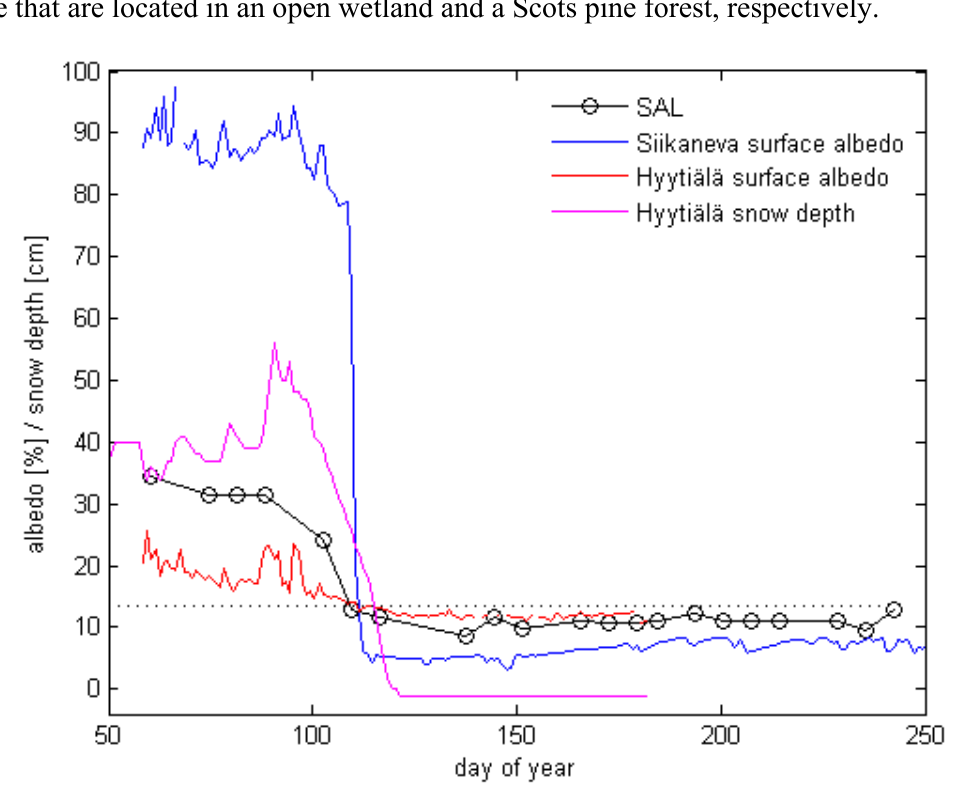
Figure 1. Time series of albedo values in Southern Finland in 2006. The coordinates of the selected SAL grid square are 61 ° 48’N, 24 ° 11’E. Siikaneva (61 ° 50’N, 24 ° 12’E) and Hyytiälä (61 ° 51’N, 24 ° 17’E) are surface observation sites within the selected SAL grid square that are located in an open wetland and a Scots pine forest,